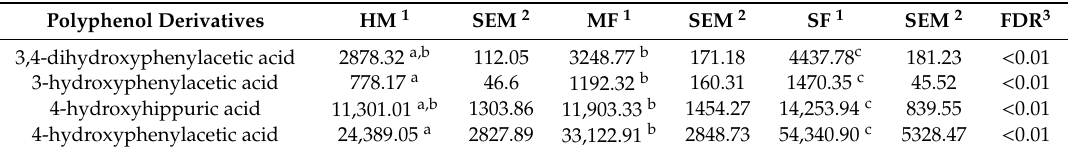
Table 6. Average abundances (quantifier ion (quantion) intensities) of urinary polyphenol microbial metabolites significantly di ff erent when comparing human milk (HM; n = 93), cow’s milk-based formula (MF; n = 80), and soy-formula (SF; n = 76) diet groups of infants at 3 months of age. Polyphenol